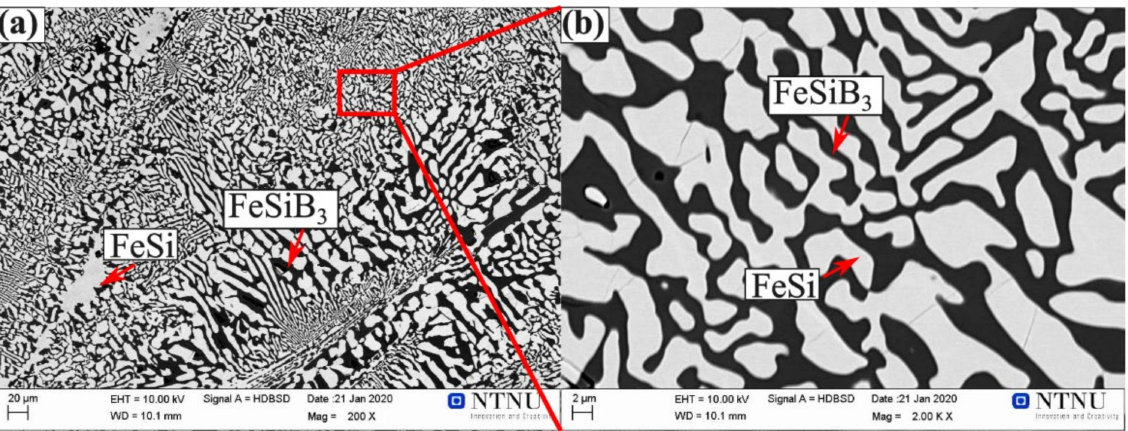
Figure 7. Images of the eutectic area in the Fe-26Si-9B alloy after six thermal cycles: ( a ) 200X; ( b ) 2000X. The red rectangle area shows the magnification position. Table 2. The detected phases in the Fe-26Si-9B alloys after experiments. All the values were obtained by WDS analyses and were normalized (at. %). Phase Fe Std. Dev. Std.